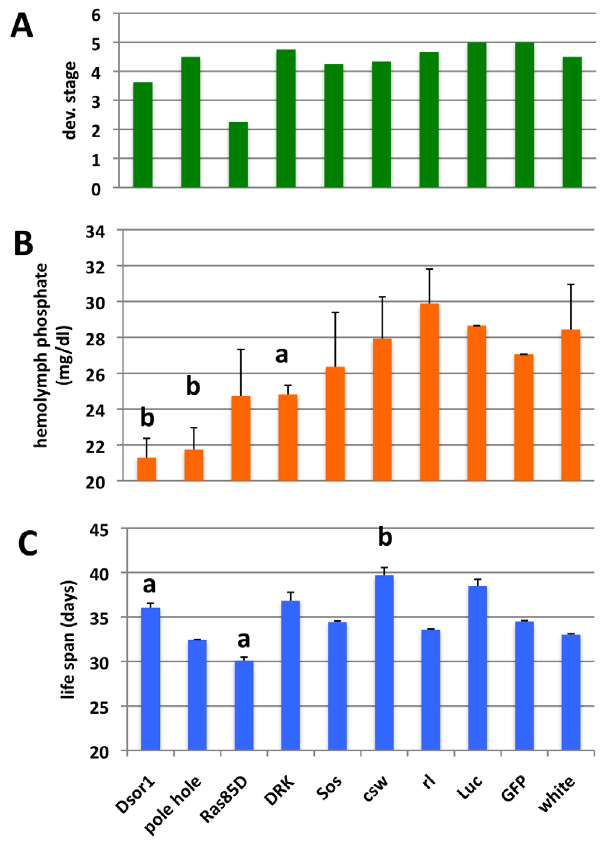
Figure 5. RNAi-mediated inhibition of MAPK-signaling invivo decreases hemolymph phosphate. A: The most advanced de- velopmental stage with induced knockdown was scored on standard medium (1=embryonic, 2=first and second instar larva, 3=third instar larva, 4=pupal lethal, 4.5=developmental delay, adult, 5=adult). B: hemolymph phosphate concentration of young adult females cultured at 29 u C for five days, and C: median life span of adult males cultured at 29 u C on standard medium (see also Table S1). a: p , 0.05, b: p , 0.007 vs. Luc/GFP/white controls. P , 0.017 was used to test for multiple comparisons between three